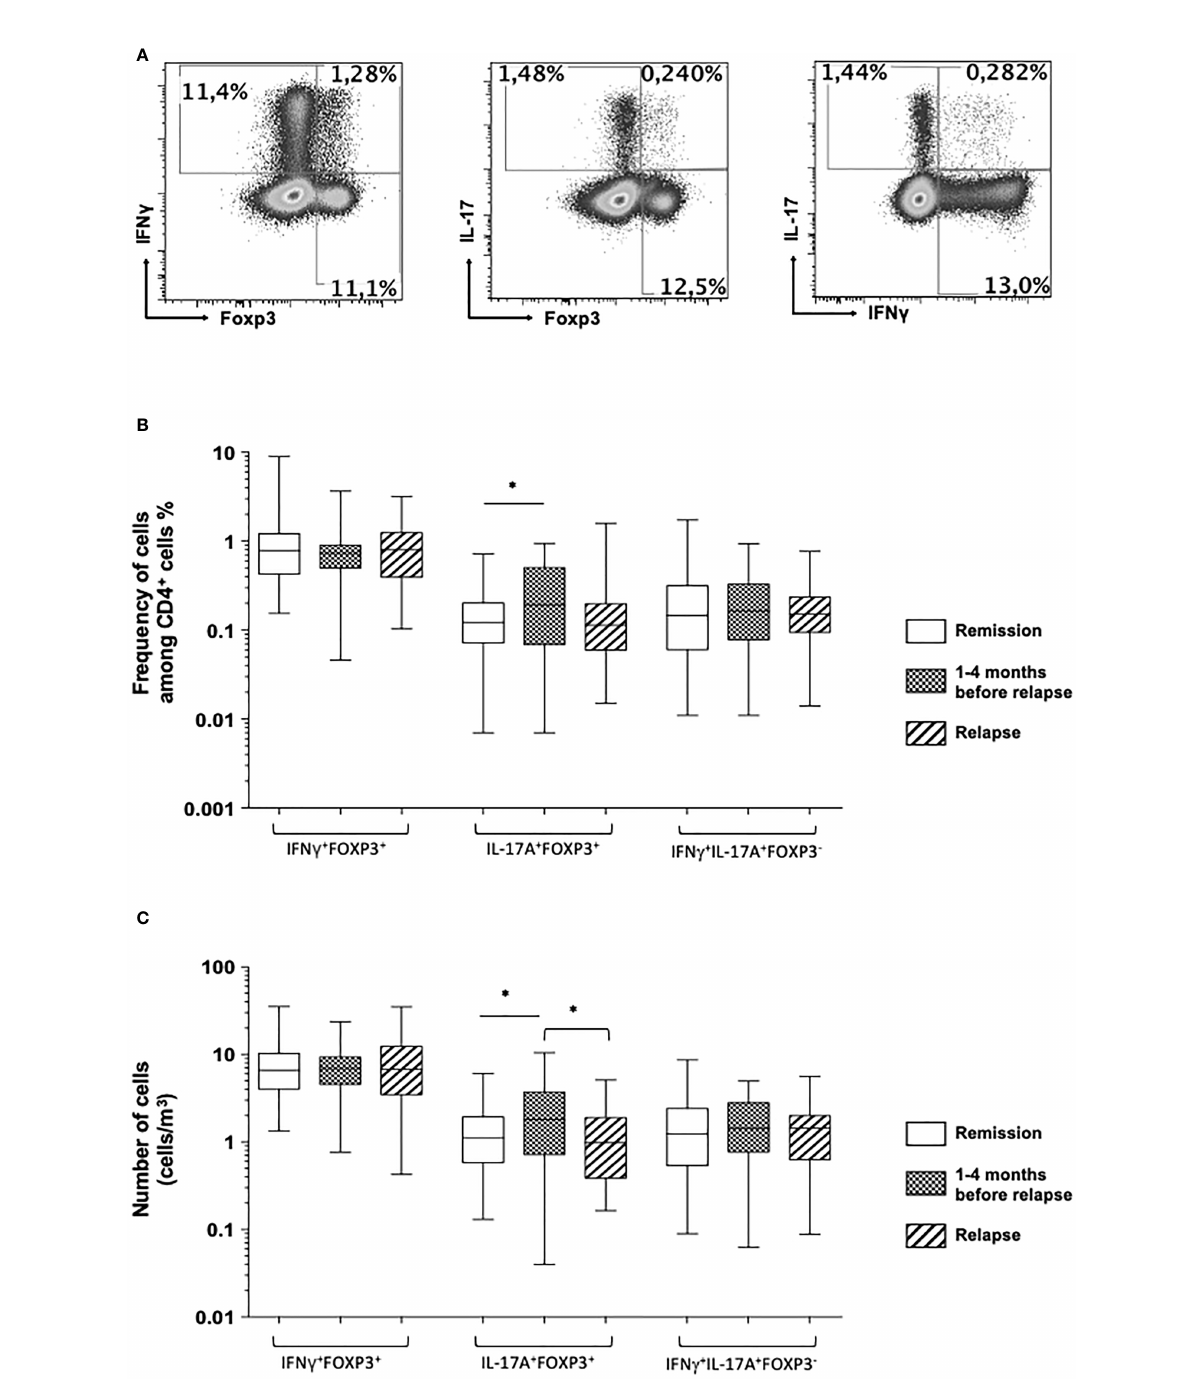
FIGURE 3 (A) Representative dot plot analysis of circulating double-positive FOXP3 and IFN g CD4 + T cell subsets (left), FOXP3 and IL-17A CD4 + T cell subsets (middle), and double-expressing IL-17A and IFN g CD4 + T cell subsets (right panel). Comparison of the frequencies (B) and absolute number (C) of the double-positive CD4 + IFN g + FOXP3 + , CD4 + IL-17A + FOXP3 + , and CD4 + IFN g + IL-17A + FOXP3 - T cell subsets among Crohn ’ s disease patients who stayed in remission all throughout the follow-up (white), those who were in remission at the time of measurement but who experienced a relapse during the following 1 – 4 months (squared), and at the time of relapse in patients who relapsed (shaded). The box plots show the median, upper, and lower quartiles of the data; the whiskers indicate the 95% con fi dence interval of the values (*p<